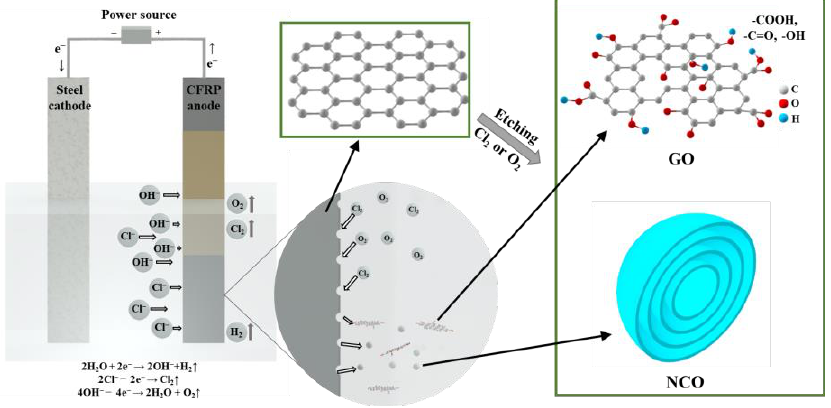
Figure 17. The schematic of GO recycling by electrochemical method.